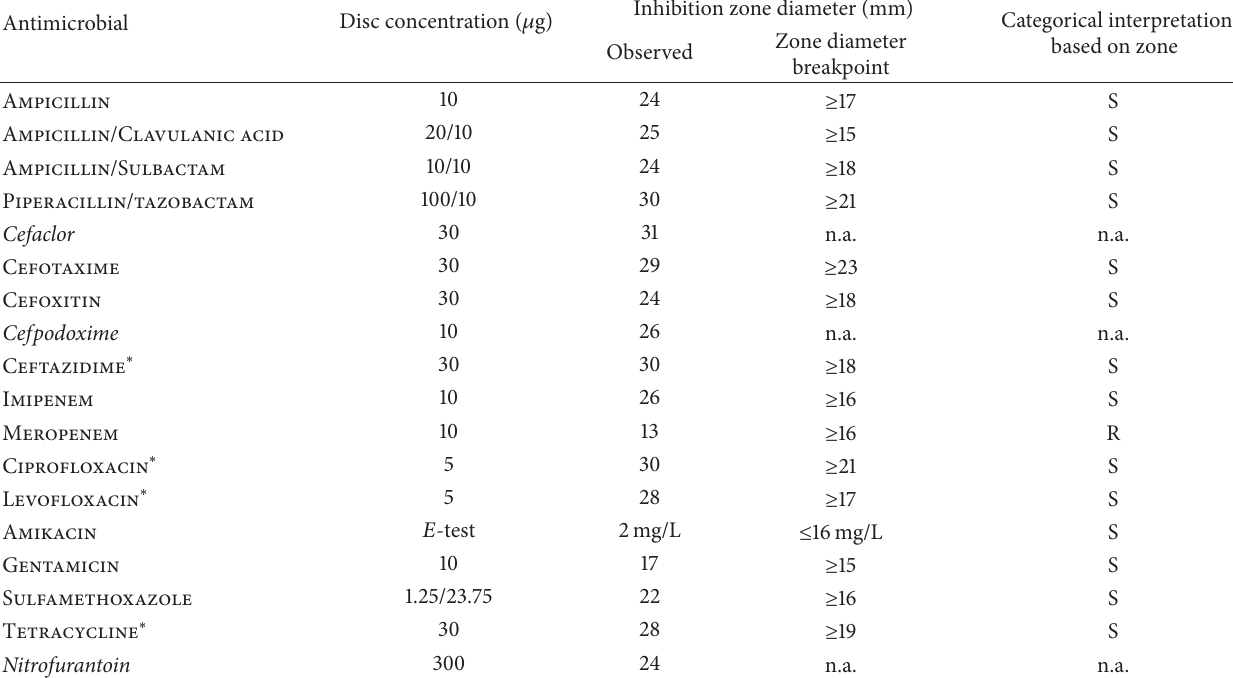
Table 2: Result of disc diffusion test (except amikacin, which was tested with 𝐸 -Test) with P. damselae on Mueller-Hinton agar after 24 hrs of incubation at 35 ± 1 ∘ C. The antimicrobials tested are those routinely used for Gram-negative isolates in the laboratory of one of us. The categorical interpretations (S: susceptible; R: resistant) are based on the CLSI recommendation for Vibrio ssp. ( excluding Vibrio cholerae ) as implemented in the Sirweb software (i2a, P´erols Cedex, France). Antimicrobials capitalized with “ ∗ ” are those recommended for first- line testing, those in Capitals indicate antimicrobials recommended for testing, and those in italics are antibiotics tested routinely in our lab with Gram-negatives on Mueller Hinton agar, but are not recommended by Clinical and Laboratory Standard Institute (CLSI) when testing Vibrio species . (n.a.: not applicable).